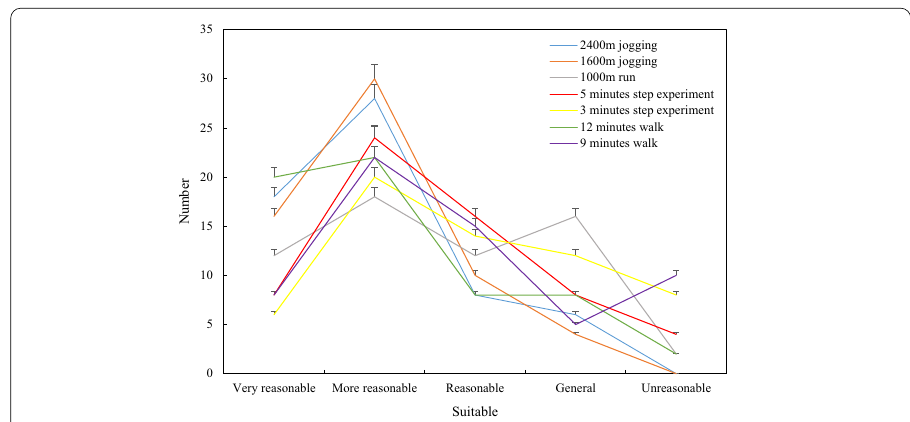
Fig. 4 Experts’ statistics on the rationality of indicators in the “Physical Fitness” cardiopulmonary endurance test of